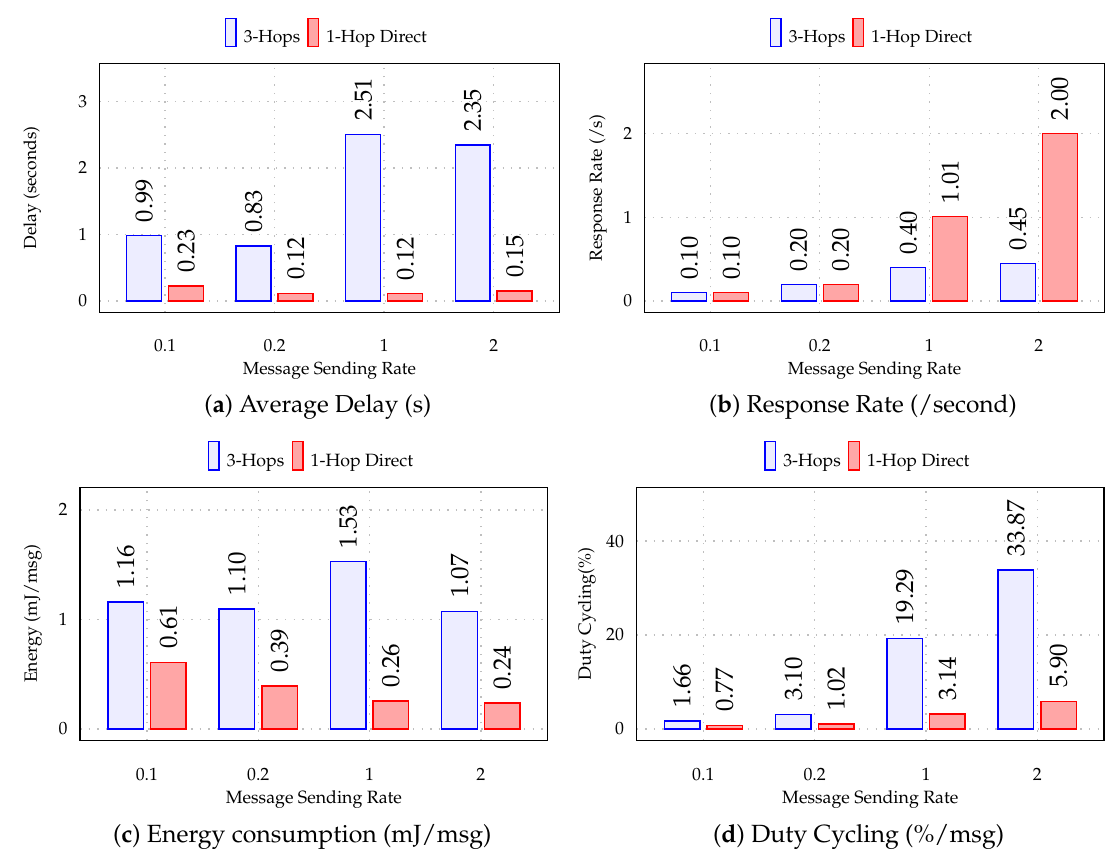
Figure 13. Results comparisons with respect to increasing message sending